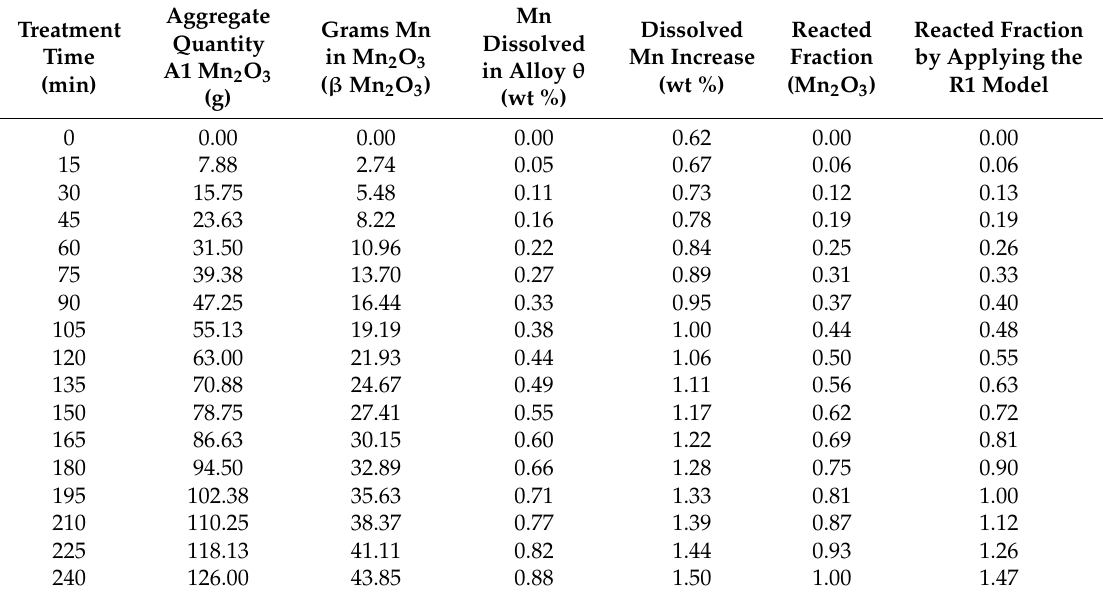
Table 3. Data calculated for the simulation of the quantities of Mn that would provide Mn 2 O 3 for each addition made, according to the time of